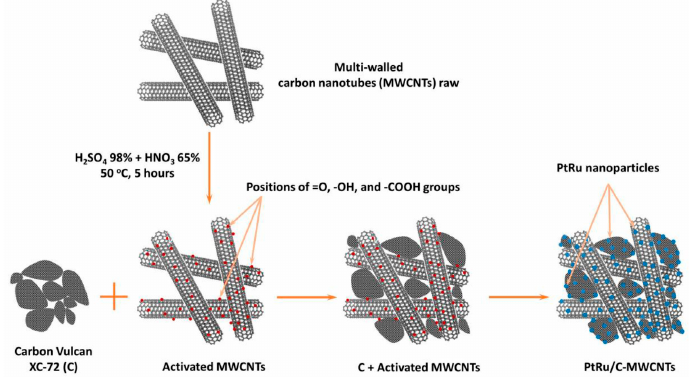
Figure 4. Schematic diagram of PtRu nanoparticles deposited on C-MWCNTs composite support, where Vulcan XC-72 carbon dispersed into the gaps between activated